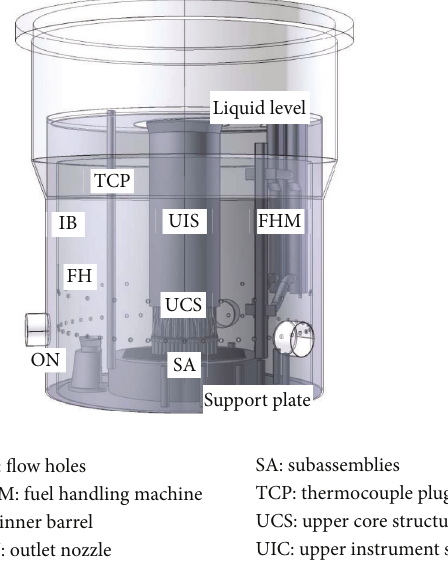
Figure 1: Sketch of the MONJU upper